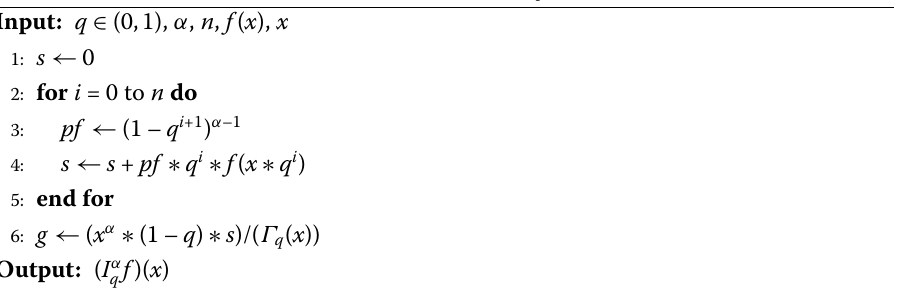
Algorithm 4 The proposed method for calculating ( I α